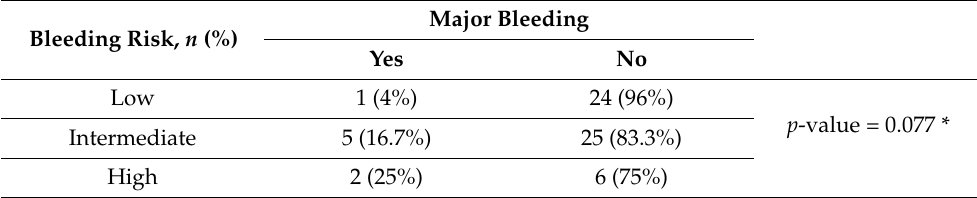
Table 3. Major bleeding rates according to BACS score risk stratification. Bleeding Risk, n